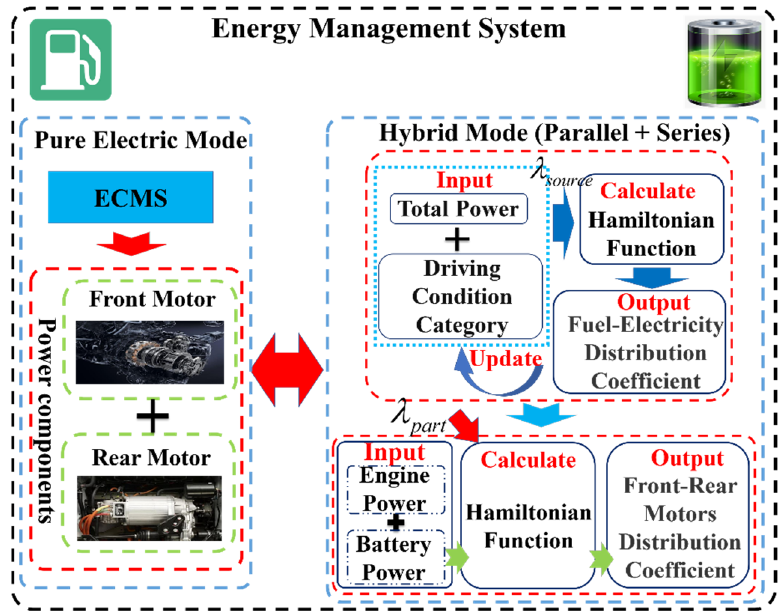
Figure 9. The architecture of the DA-ECMS. The DA-ECMS optimizes the distribution of energy output between power sources, while the front/rear axles electric driving system is optimally managed. In order to give full play to the energy-saving potential of the 4WD PHEV, the equivalent factors are adaptively adjusted according to different driving condition categories to improve the driving condition adaptability and robustness and improve the economy of the vehicle. The energy distribution optimization between power sources is shown in Equation